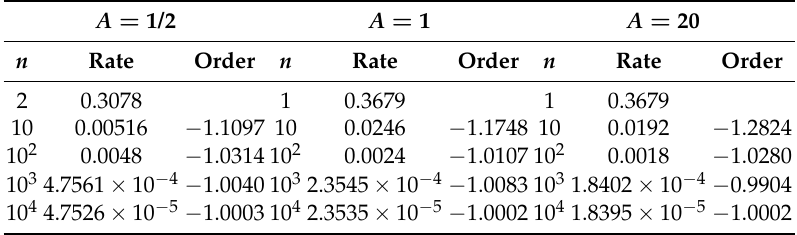
Table 2. Uniform convergence rate and convergence order for uniform distribution.